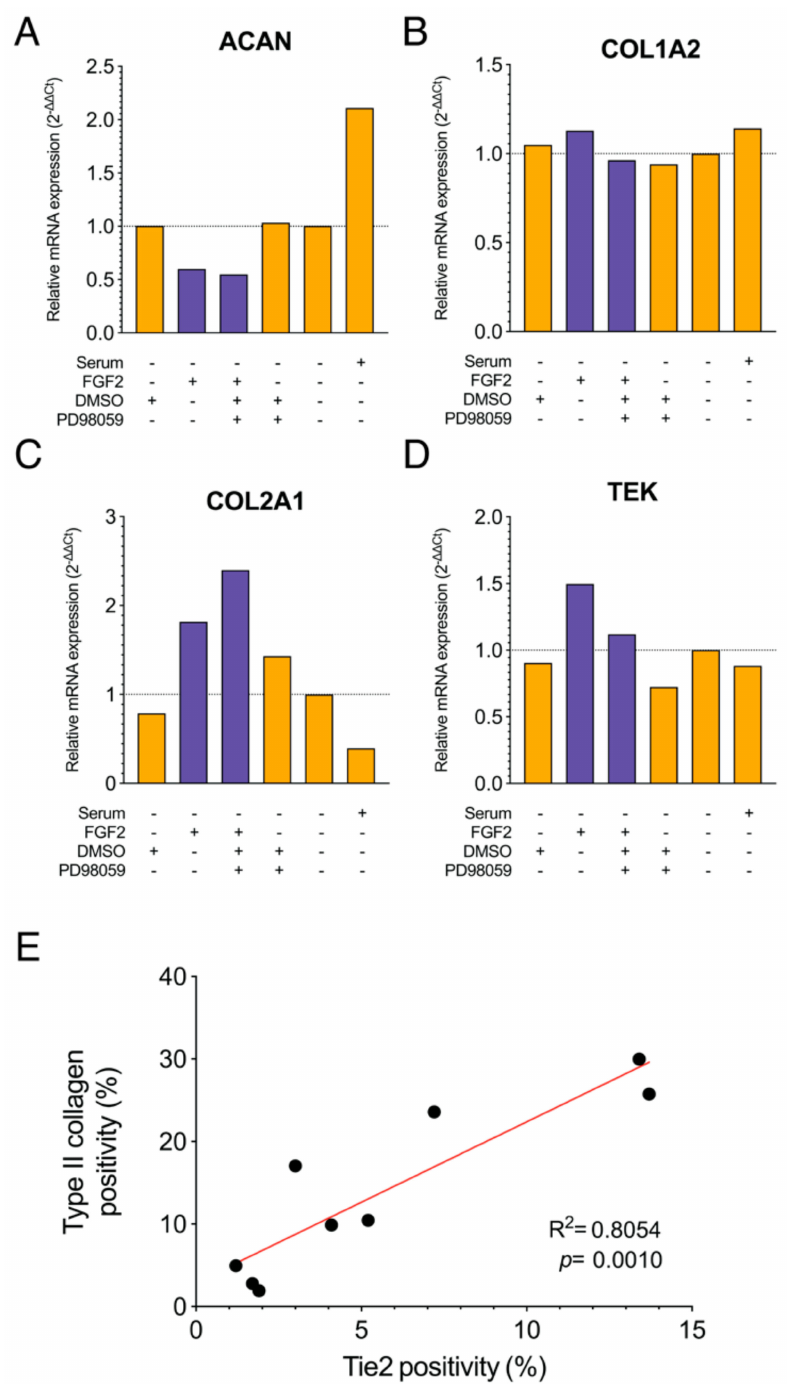
Figure 4. Assessment on the effect of FGF2 on matrix production of potency. RT-PCR data ( n = 1) for nucleus pulposus (NP) cell ( A ) ACAN, ( B ) COL1A2, ( C ) COL2A1, and ( D ) TEK: gene of Tie2. mRNA expression levels calculated relative to GAPDH, and subsequently to unstimulated serum- starved conditions. Purple bars: FGF2 included, Orange bars: FGF2 non-included. ( E ) Simple linear regression analysis of flow cytometry outcomes correlating fraction of Tie2 positivity and type II collagen positive NP